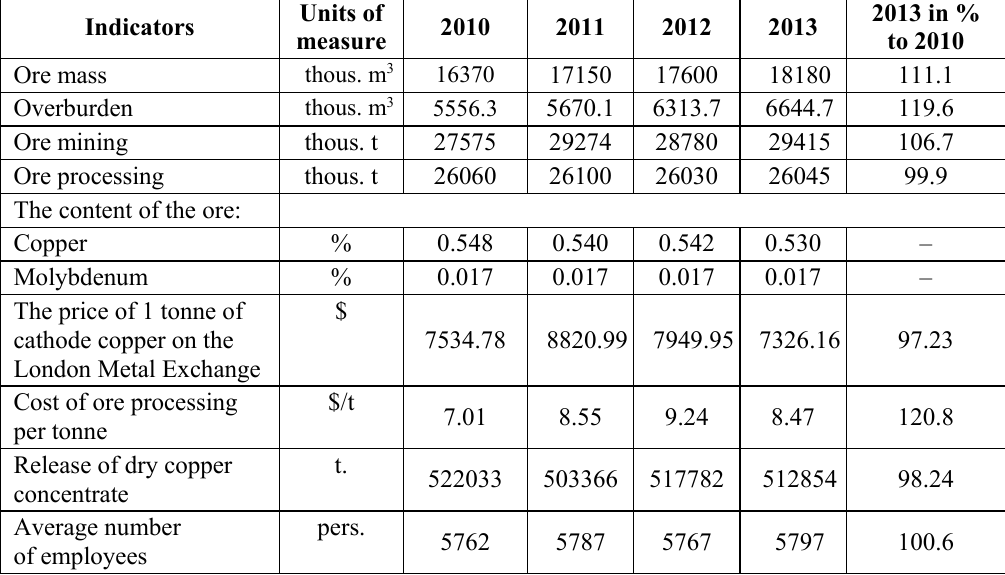
Table 1. Main Production and Economic Indicators of the Mining Enterprise Erdenet (made by the authors based on the data by LLC Erdenet, 2015)